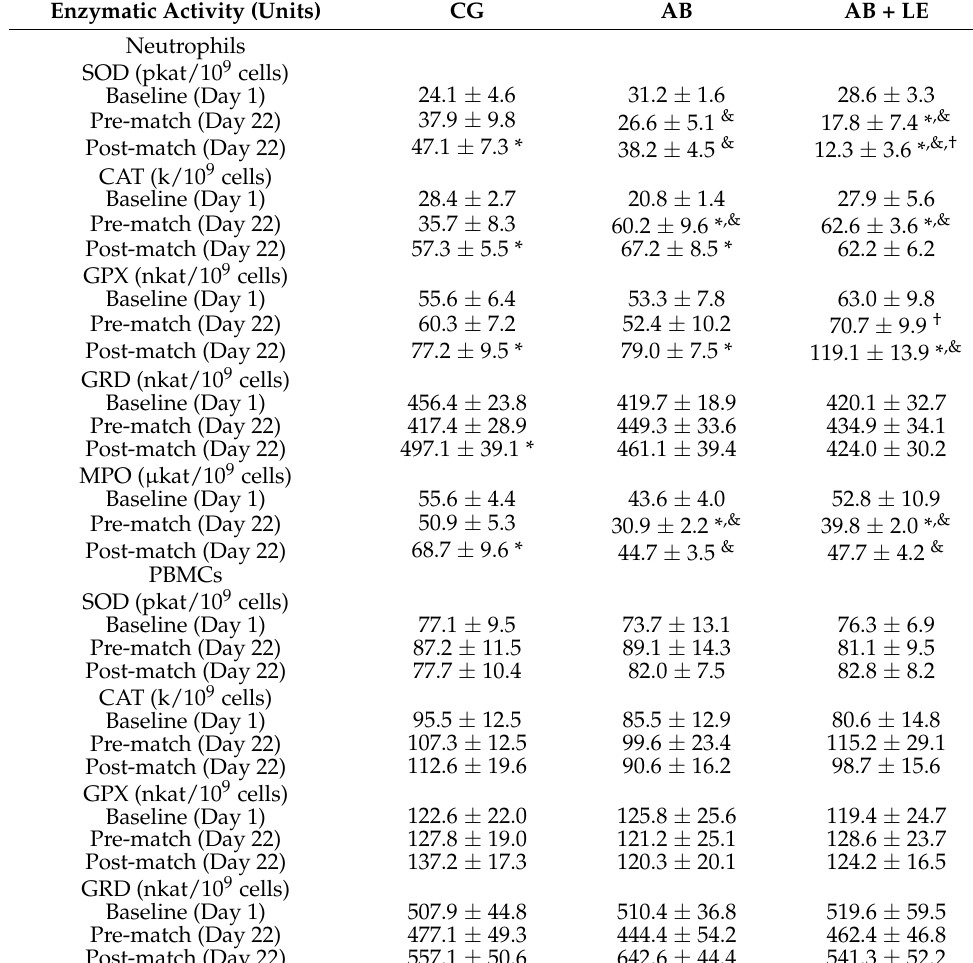
Table 4. Activities of antioxidant enzymes in neutrophils and PBMCs and myeloperoxidase in neutrophils determined under baseline conditions, pre-match and immediately post-match in the control (CG), almond beverage (AB) and almond beverage + Lippia extract (AB + LE) groups. Enzymatic Activity